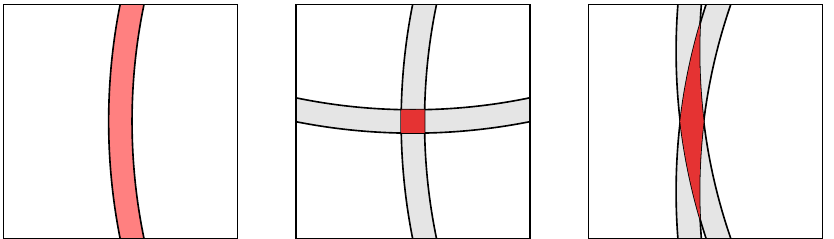
Figure 12. Dilution of Precision. Left: constraint from single distance measurement; Middle: favorable combination of constraints; Right: unfavorable combination of constraints. The area of the overlap grows as 1/ sin ( θ ) , where θ is the angle between the directions to the APs.